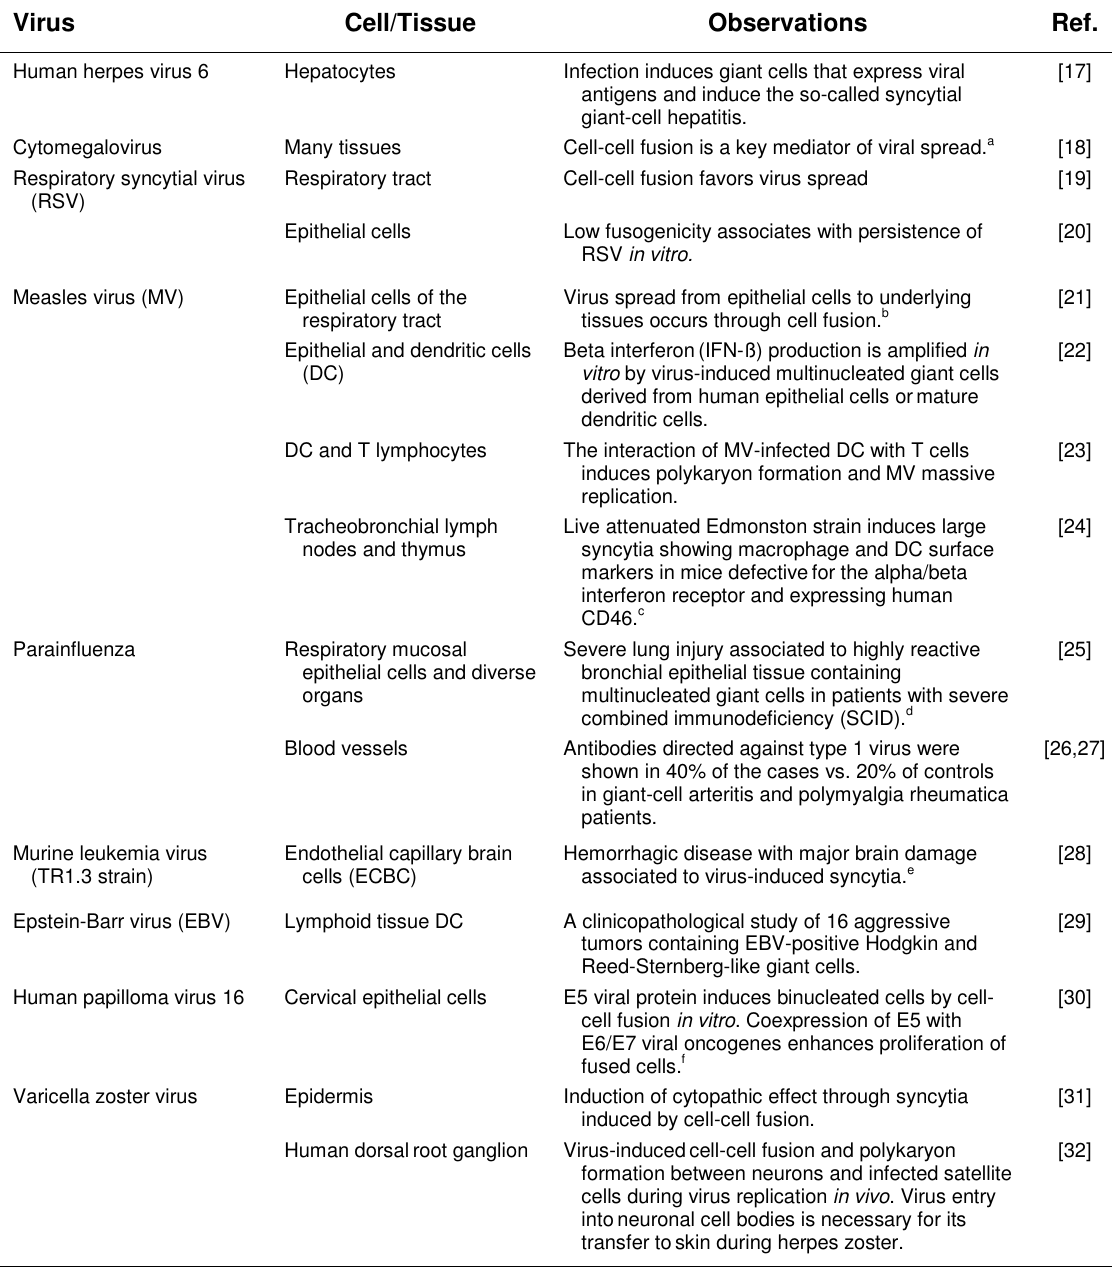
Some Events Associated with Syncytia Formation in Pathogenic Viral Infections Virus Cell/Tissue